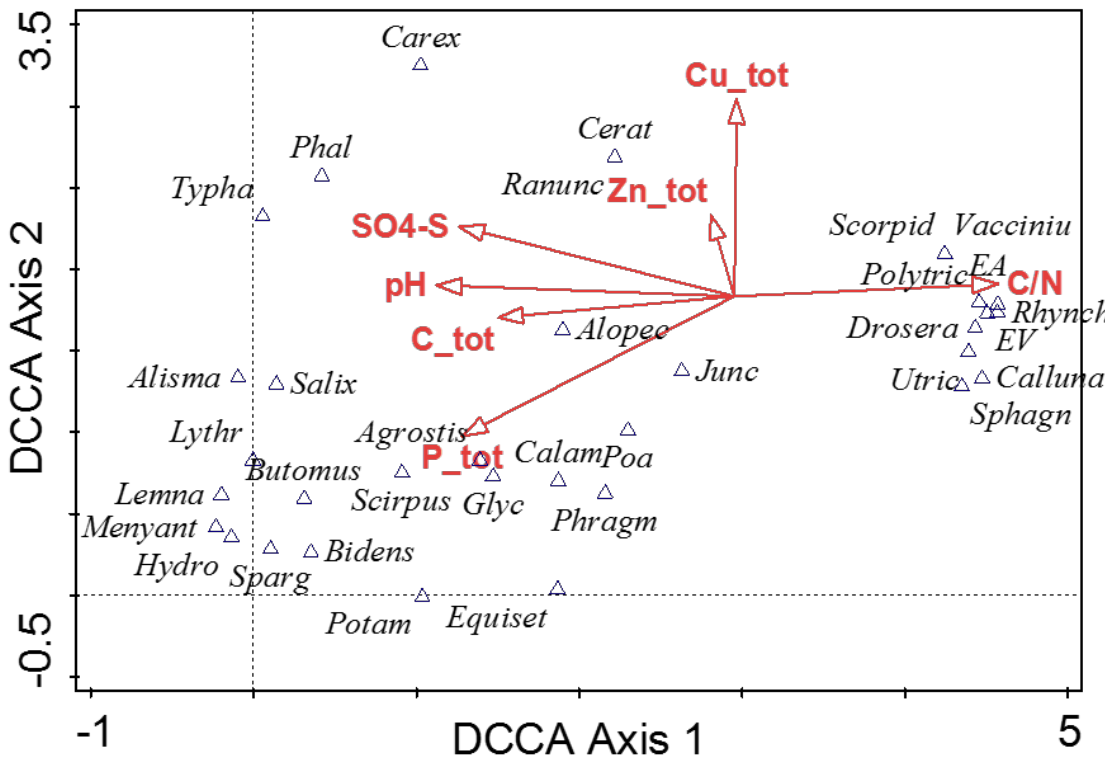
Figure 7. Detrended Canonical Correspondence Analysis (DCCA) of plant species and environmental variables based on 48 vegetation relevés at Västkärr and 80 vegetation relevés at Porla (22 vegetation relevés at Västkärr and 15 at Porla were excluded because of lack of environmental data). Relative positions of plant species are marked by unfilled triangles. Environmental variables (red arrows) with variance inflation factor ≤ 20 are shown. Total variation is 5.13. Explanatory variables account for 26.1 % of total variation (adjusted explained variation 21.8 %). Abbreviations of plant species are given in Tables 3 and 4, and of environmental variables in Figure